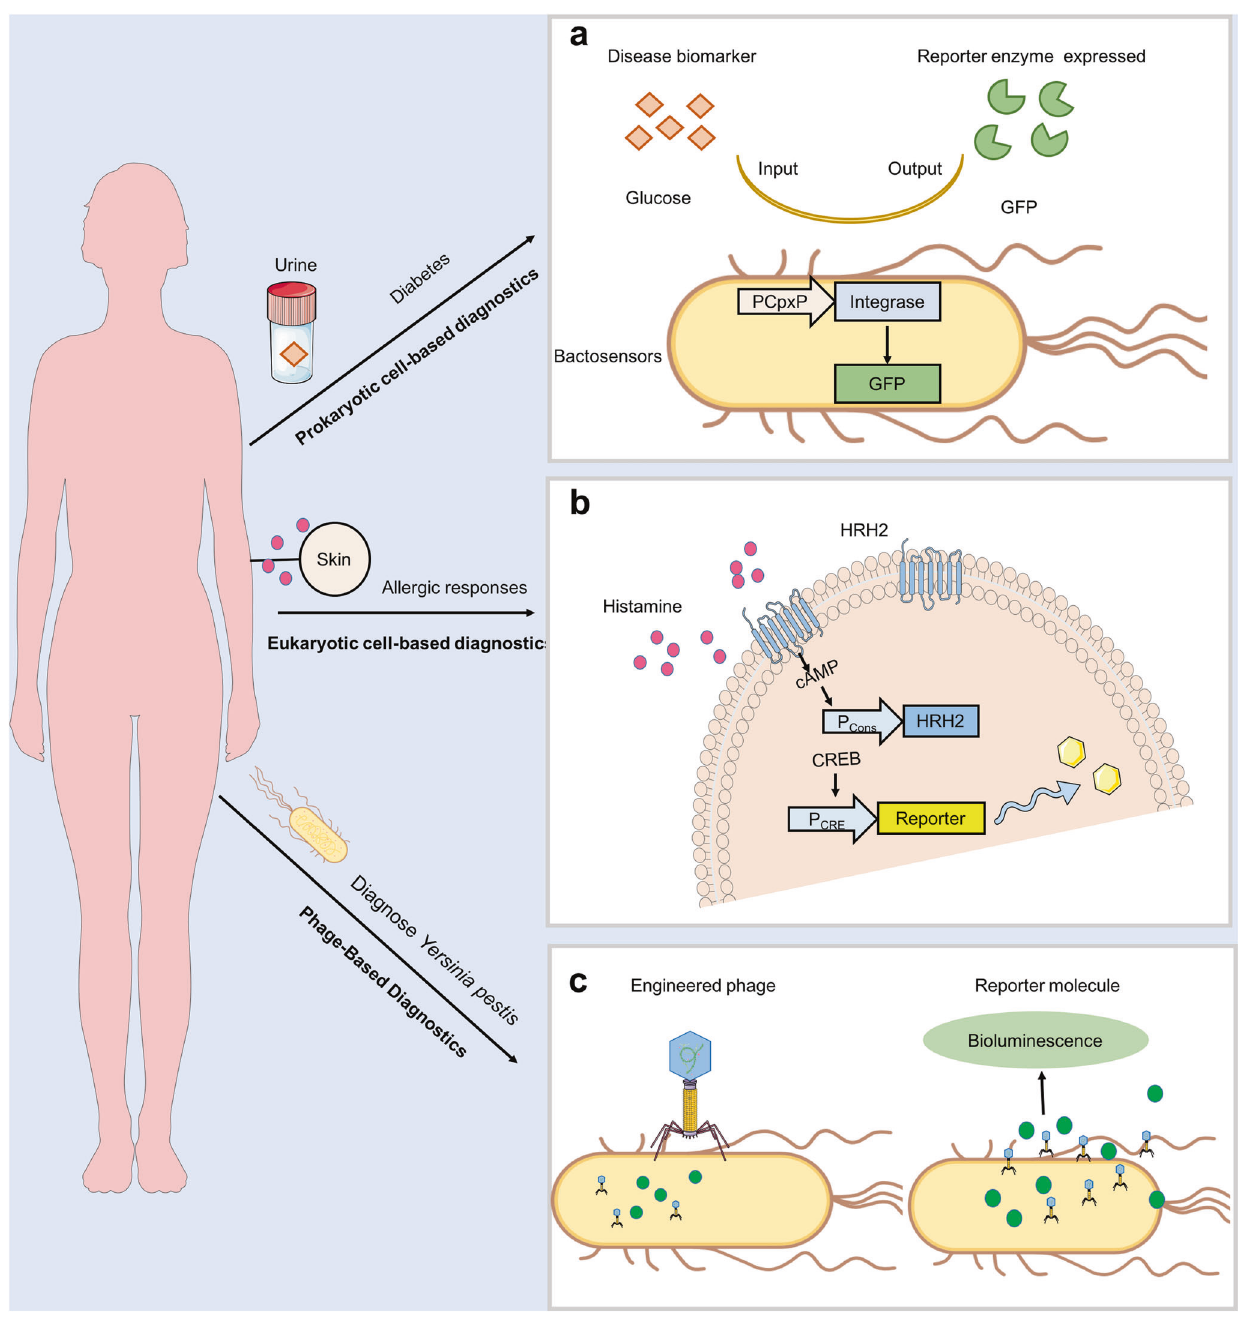
Fig. 2 Synthetic biology platforms for diagnostics. a Schematic representation of engineered bacteria sense-and-respond systems adopt disease biomarkers (orange quadrilateral) to sense disease, in turn, produce a diagnostic readout such as β -lactamase and green fl uorescent protein (GFP) (green Pacman). b Applications of mammalian synthetic biology in diagnostics. Monitoring of allergic immune by engineered mammalian cell encoding the histamine sense-and-response device. The constitutively expressed histamine-responsive receptor HRH2 sense histamine and triggers an endogenous signaling cascade leading to expression of a reporter protein. c Phage-based diagnostics rely on engineered phage can speci fi c recognition of target bacterial species. Once the engineered phage bound to the target cells, the genome is injected into it then the phage replicate and reporter gene expressed